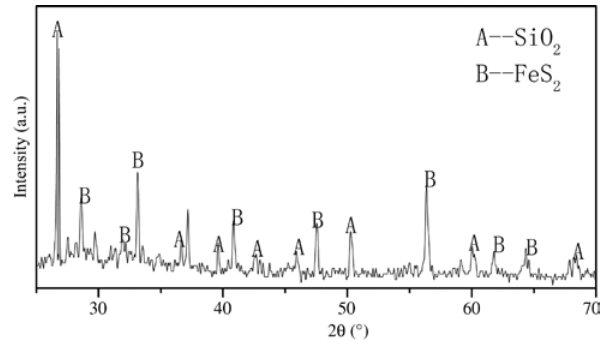
Figure 6: X-ray diffraction of leaching